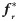
Dependence between the flow resistance coefficient fr* and the Reynolds number Ref* for the investigated emulsions.